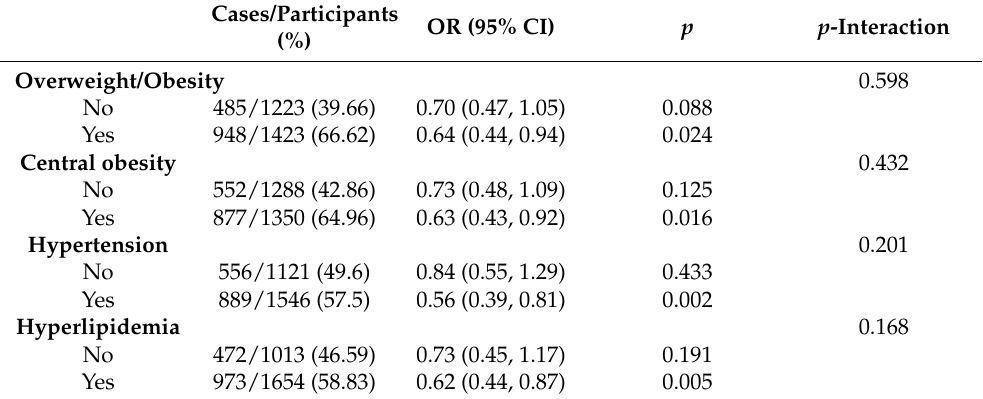
Table 4. Standard β coefficient with 95% confidence intervals for the fatty liver index according to daily fruit and vegetable intake.